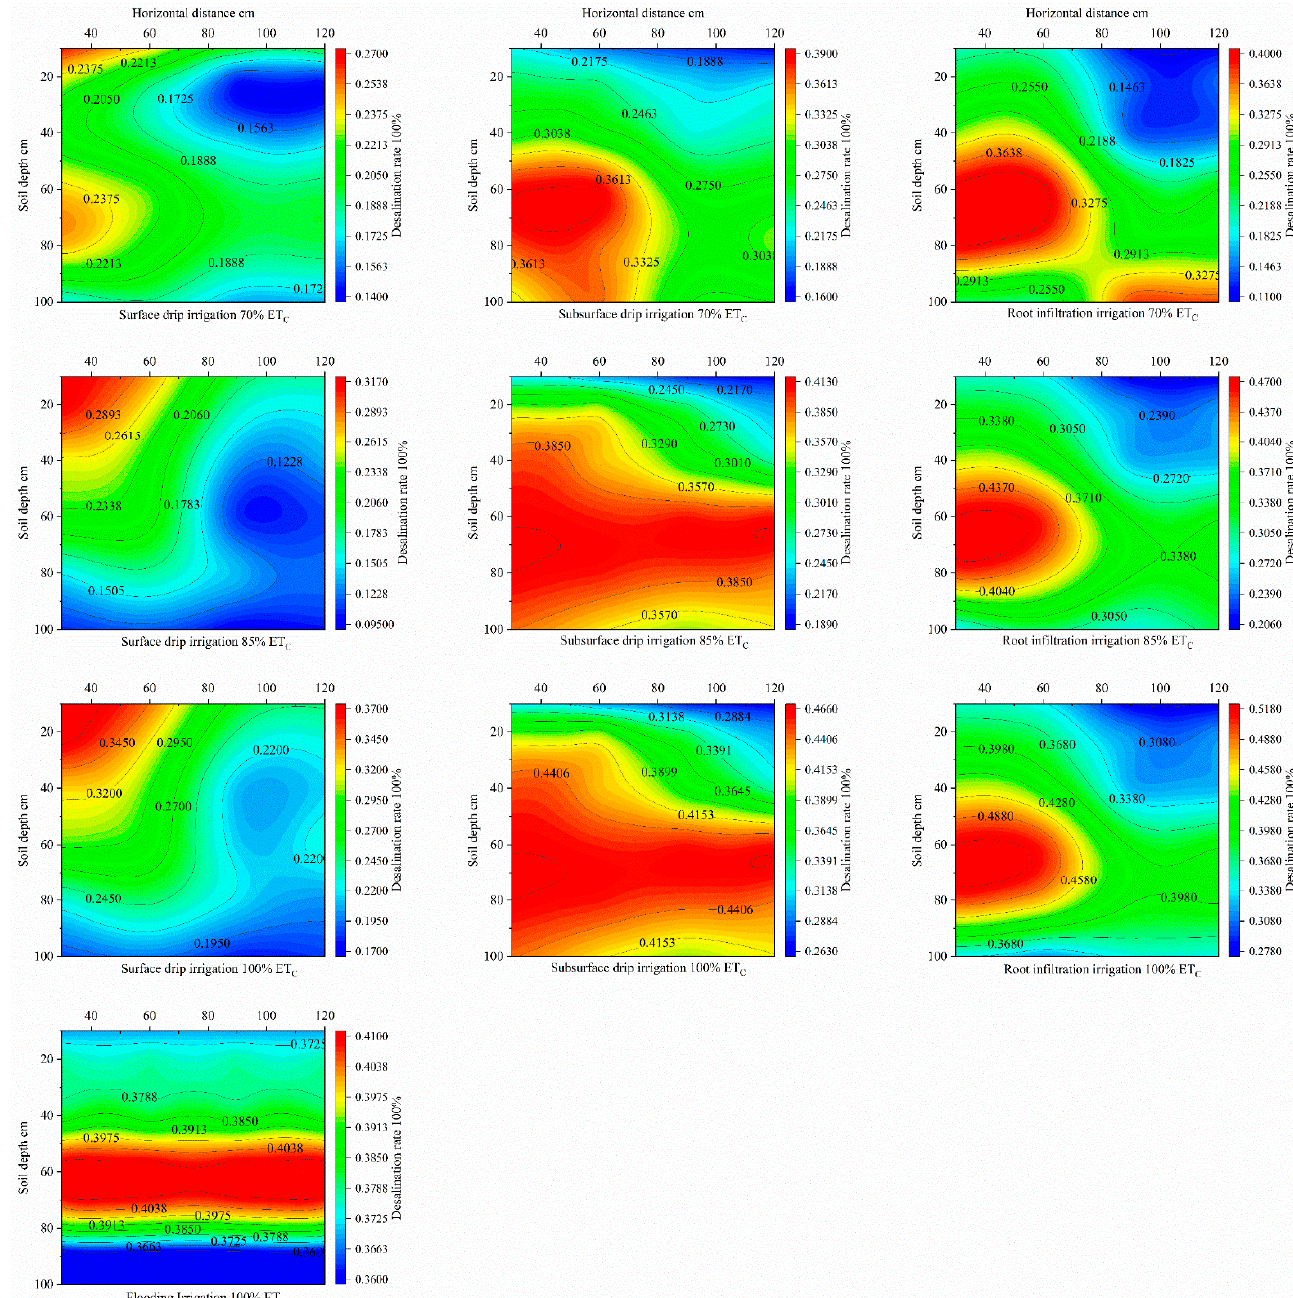
Figure 7. Changes in the desalination rate under different irrigation methods. that under F1, 8.3% lower than that under F2, and 11.0% lower than that under F3. In the 20–100 cm soil layer, the soil salt content after flooding irrigation in the soil 0–80 cm away from the tree trunk in the horizontal direction was higher than that for the F2 and F3 treatments, but the soil salt content after flooding irrigation in the soil 80–120 cm away from the trunk in the horizontal direction was lower than that for the F2 and F3